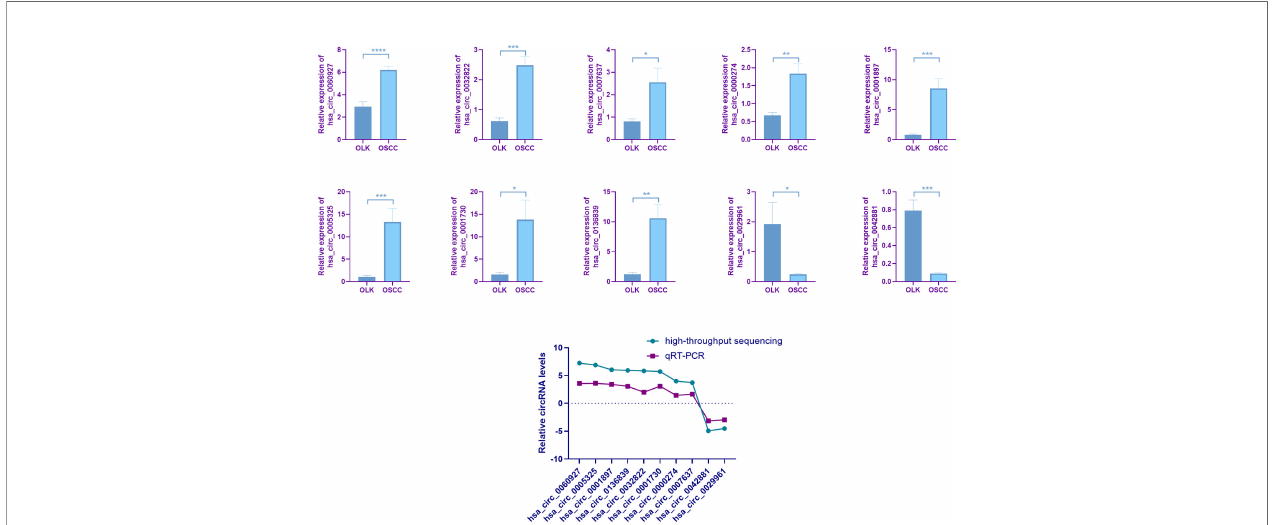
FIGURE 2 | Quantitative real-time PCR (qRT-PCR) veri fi cation. Six pairs of tissues from patients with oral leukoplakia (OLK) and oral squamous carcinoma cell (OSCC) were used for validating by qRT-PCR. Ten selected circRNAs showed relative expression in OLK compared with OSCC. All the ten circRNAs, has_circ_0060927 ( p < 0.0001), has_circ_0032822 ( p < 0.001), has_circ_0007637 ( p < 0.05), has_circ0000274 ( p < 0.01), has_circ_0001897 ( p < 0.001), has_circ_0005325 ( p < 0.001), has_circ_0001730 ( p < 0.05), has_circ_0136839 ( p < 0.01), has_circ_0029961 ( p < 0.05), and has_circ_0042881 ( p < 0.001), exhibited the same expression trend toward the sequencing results. The results of ten veri fi ed circRNAs of high-throughput sequencing and qRT-PCR were exhibited together as logFC (fold change) in the OLK group. (* p < 0.05, ** p < 0.01, *** p < 0.001, **** p <